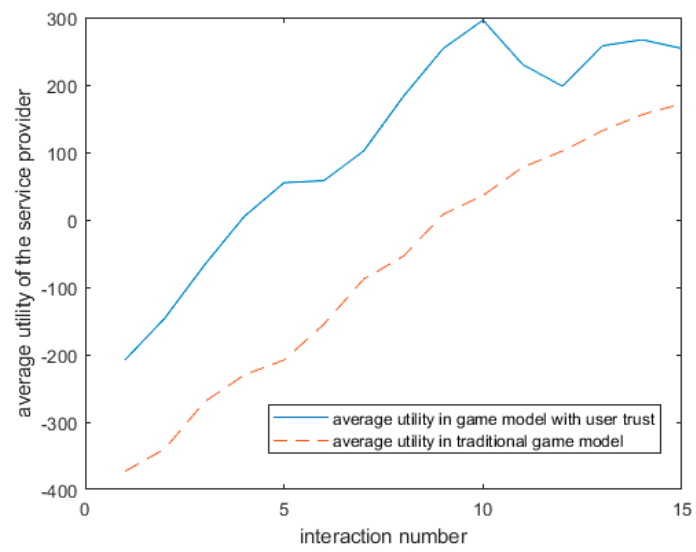
Figure 3. Utility comparison curves between the traditional game and the proposed game with user trust.